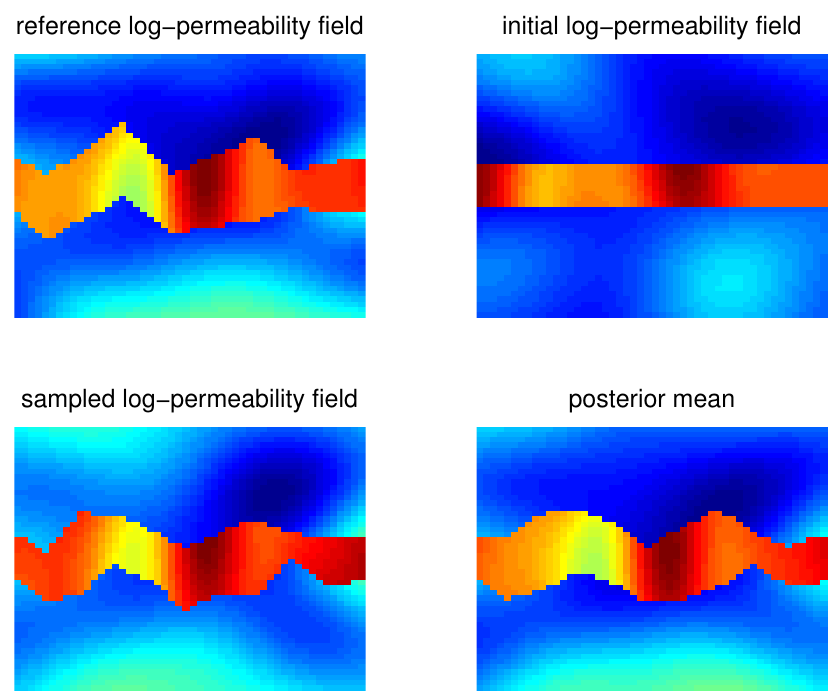
Figure 9. Top left : The true log-permeability field. Top right : Initial log-permeability field. Bottom left : One of the sampled log-permeability field. Bottom Right : The mean of the sampled log- permeability field from two-stage MCMC using 25 K-L terms.